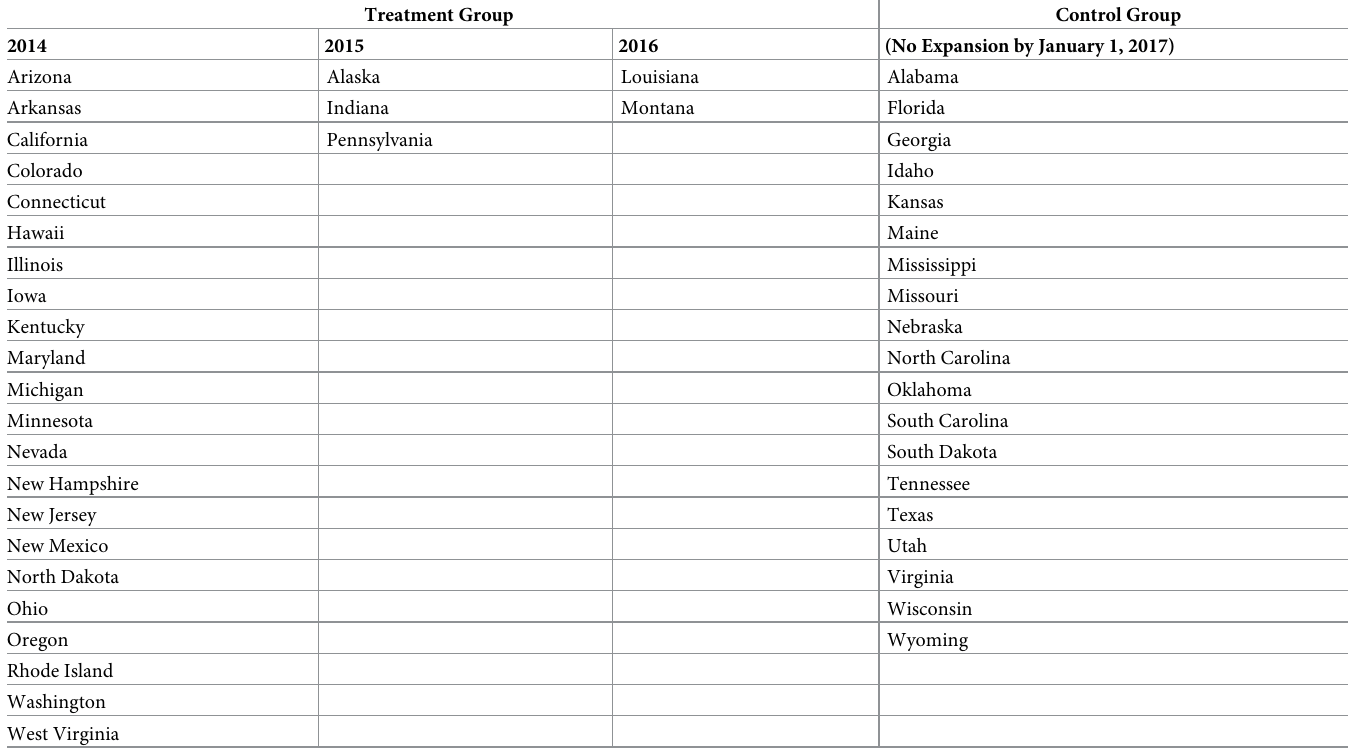
Table 1. Summary of ACA Medicaid expansion adoption as of January 1,